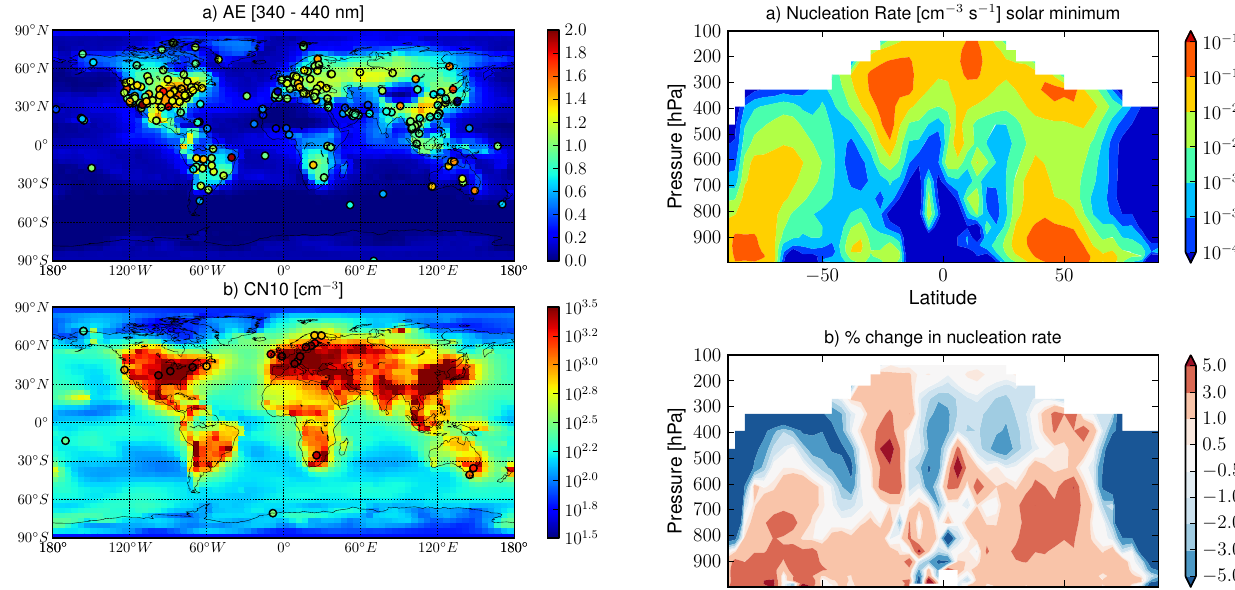
Fig. 3. Model-predicted Angstrom Exponent (340-440nm) (panel a ) and surface CN10 concentrations (panel b ) for BASE solar- maximum simulations. Measurements of Angstrom Exponents from AERONET sites with at least 1000 measurements are shown in colored circles in panel (a) . Measurements of CN10 compiled by Pierce et al. (2007) and Yu and Luo (2009) are shown in colored circles in panel (b) .